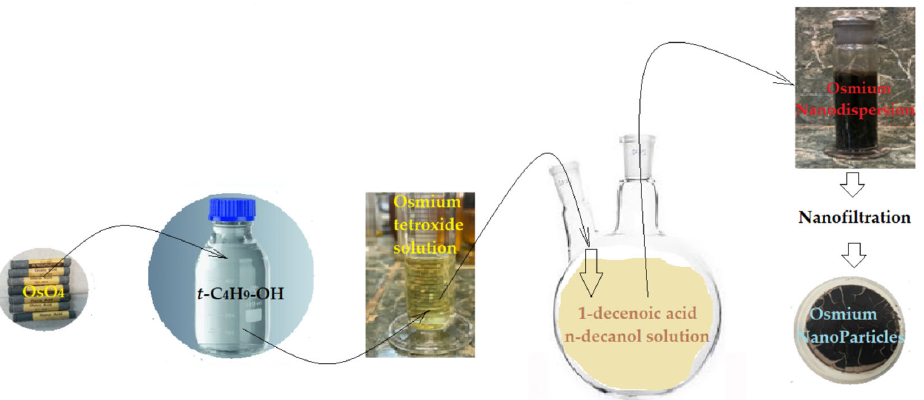
Figure 2. Schematic presentation of obtaining the osmium nanoparticles and their dispersion in n ‐ decanol.